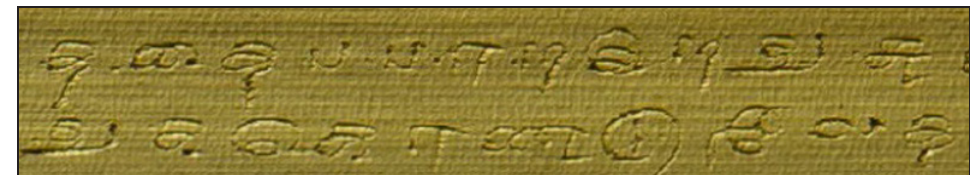
ki atu in extract from Folio 55 r in MS Indien 291 (BnF, Figure 16: pā ṟ ṟ